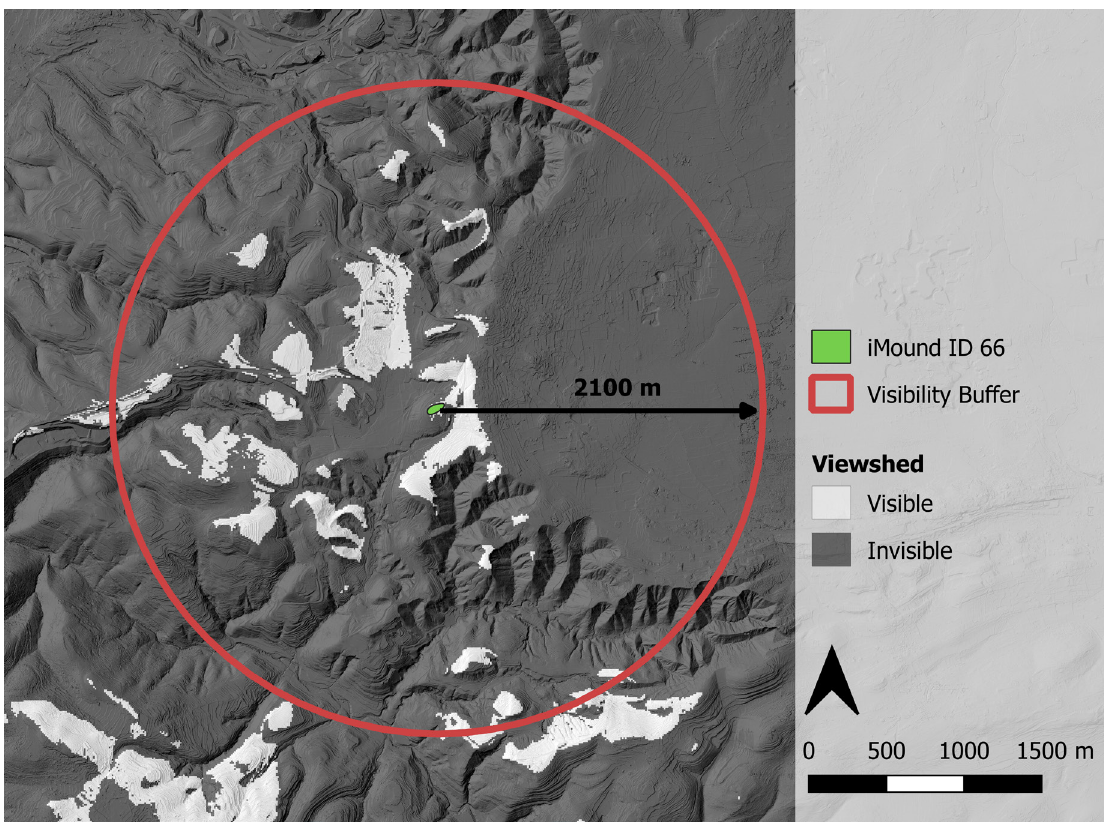
Figure 7: Calculation of the visibility (V) using the example of iMound ID 66. Visible areas are marked in white, invisible areas in